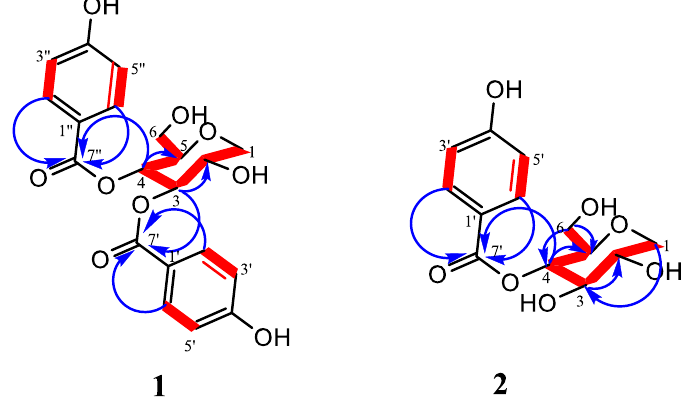
Figure 2. Key HMBC ( → ) and COSY ( — ) correlations of compounds 1 and 2 . Compound 2 was obtained as white crystals. The molecular formula was established as C 13 H 16 O 7 by the positive-ion HRESI-MS, which showed molecular ion [M+H] + at m / z 285.0978 (calc. for 284.3659). Compound 2 was somewhat similar to compound 1, indicating that the structures of both compounds were closely related, and the only difference was likely the absence of the 4-benzoate moiety in compound 2 . The 1 H NMR data indicated the presence of two intense protons resonating as doublets in the aromatic region at δ H 7.83 (2H, d , J = 8.8 Hz, H-2 (cid:48) /H-6 (cid:48) ), and 6.75 (2H, d , J = 8.8 Hz, H-3 (cid:48) /H-5 (cid:48) ) indicating the presence of 4-hydroxybenzoate moiety. The other protons resonated δ H 4.81 (1H, t , J = 9.3 Hz, H-4), 3.89 (1H, dd , J = 11.2, 4.6, H-1b), 3.51 (1H, m , H-2), 3.51 (1H, m , H-3), 3.49 (1H, m , H-6b), 3.40 (1H, m , H-6a), 3.38 (1H, m , H-5), and 3.16 (1H, t , J = 10.6 Hz, H-1a), reminiscent of the presence of a sugar or open oxygenated chain moiety. Inspection of the 13 C NMR data showed signals indicative of the 4-hydroxybenzoyl moiety resonating at δ